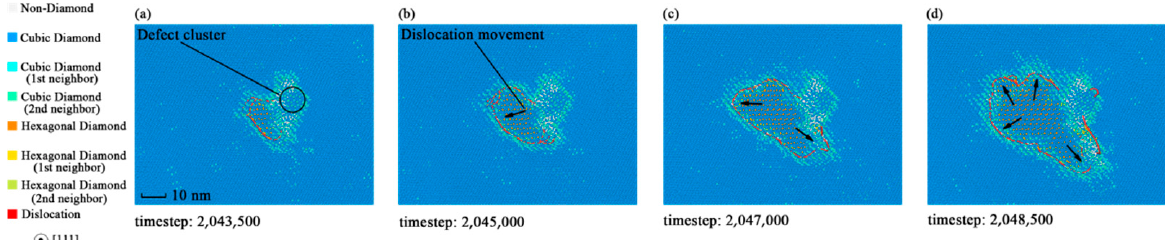
Figure 9. Dynamic behaviors of dislocation in specimen 3 during the process of fracture: ( a ) Dislocation snapshot at timestep 2,043,500; ( b ) dislocation snapshot at timestep 2,045,000; ( c ) dislocation snapshot at timestep 2,047,000; ( d ) dislocation snapshot at timestep 2,048,500.